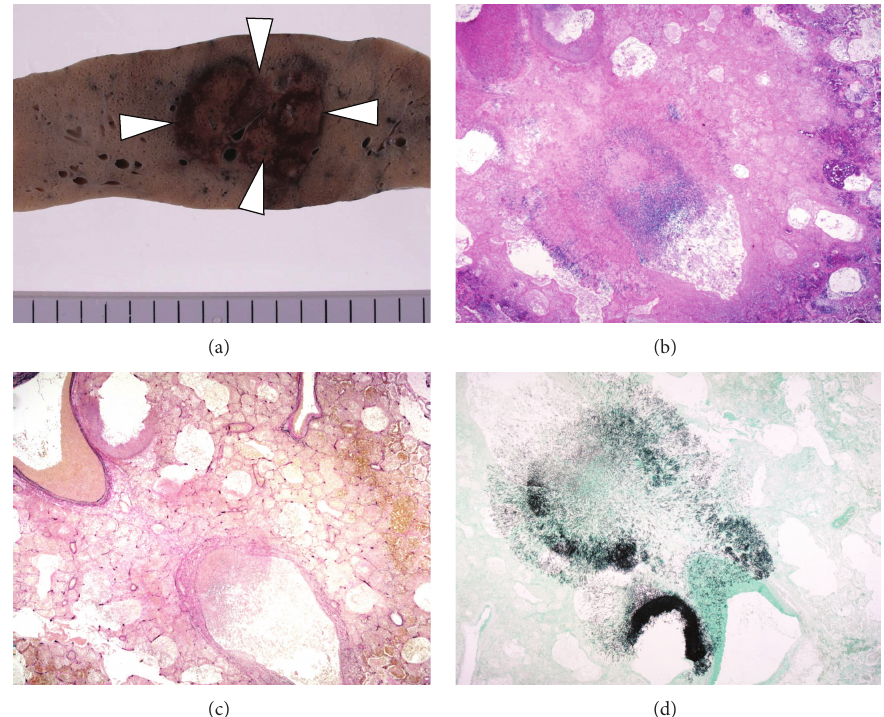
Figure 3: Invasive pulmonary aspergillosis with infarction. (a) There is a sharply demarcated nodule on a section of the lung (white arrow head). (b) Fungus hyphae can be seen in the vessel. Coagulation necrosis can be seen surrounding the vessel (Hematoxylin-Eosin, X20). (c) The pulmonary structure is not destroyed by the fungi (Elastica van Gieson, X20). (d) Hyphae aligned in a radial pattern within the vessel and airspace (GMS, X20).